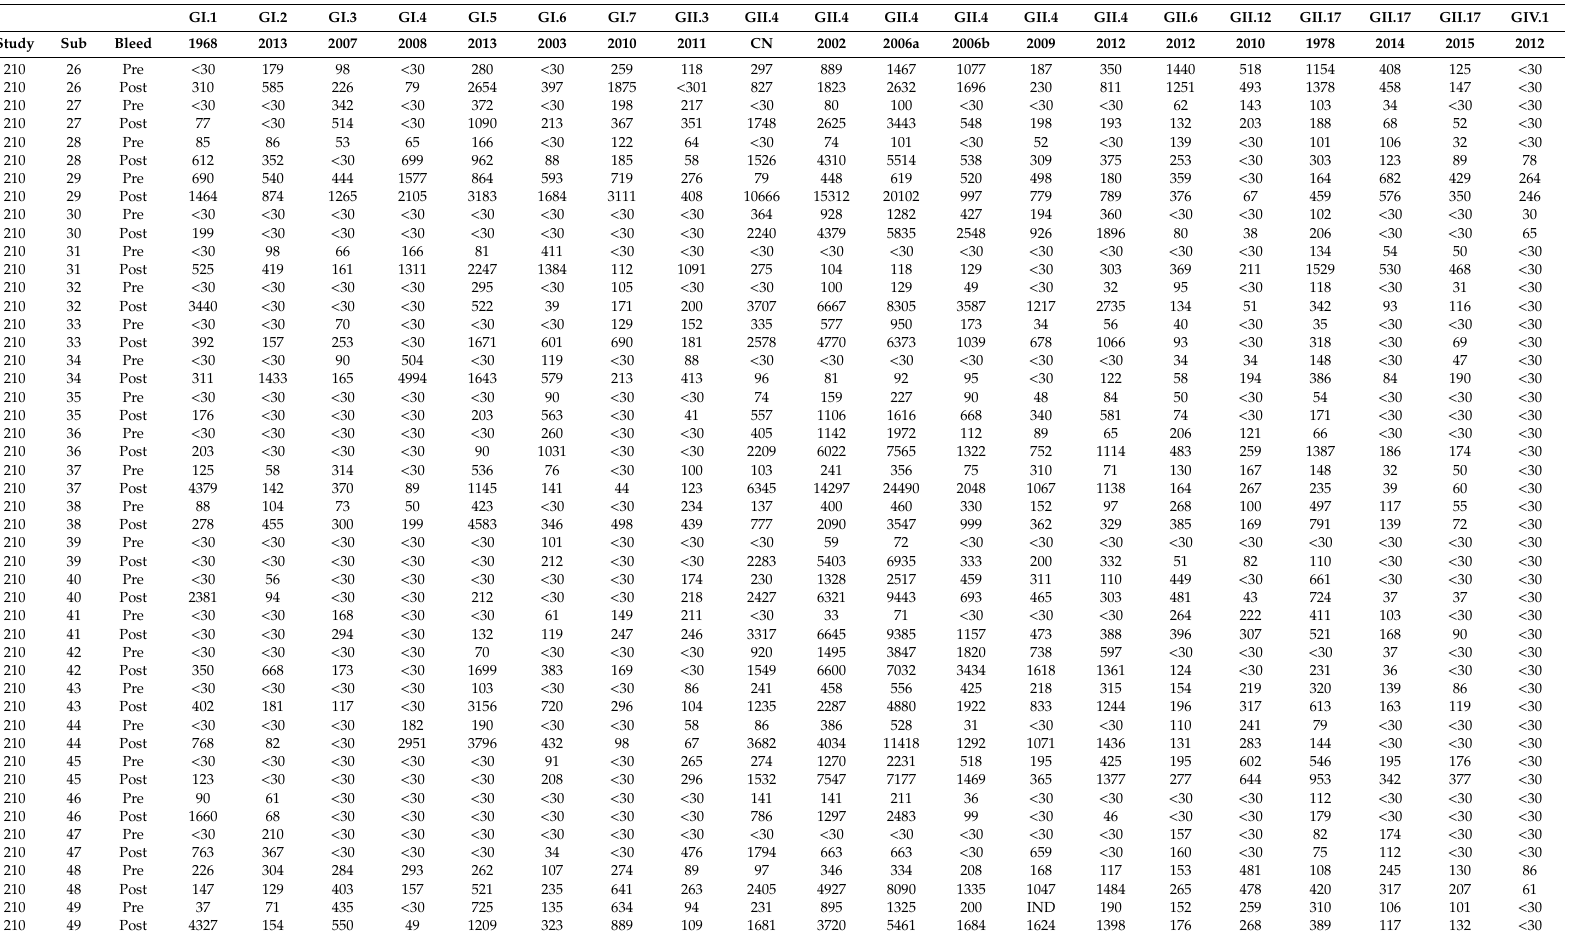
Table A3. Blockade titers measured in sera from subjects enrolled in the NOR-210 clinical